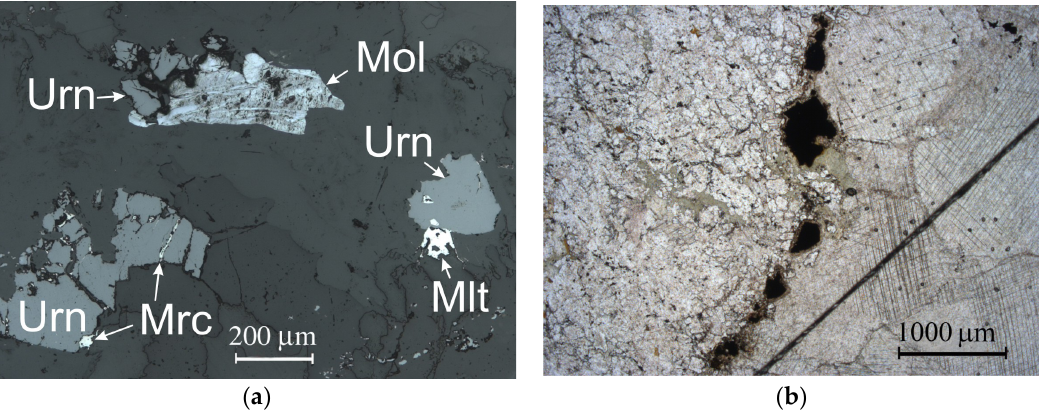
Figure 5. Uranium minerals in metasomatites of the Ozernoe U-occurrence: ( a ) uraninite (Urn) with molybdenite (Mol), marcasite (Mrc), melonite (Mlt); ( b ) a chain of brannerite grains at the boundary of albitite (on the left) and dolomite metasomatite.